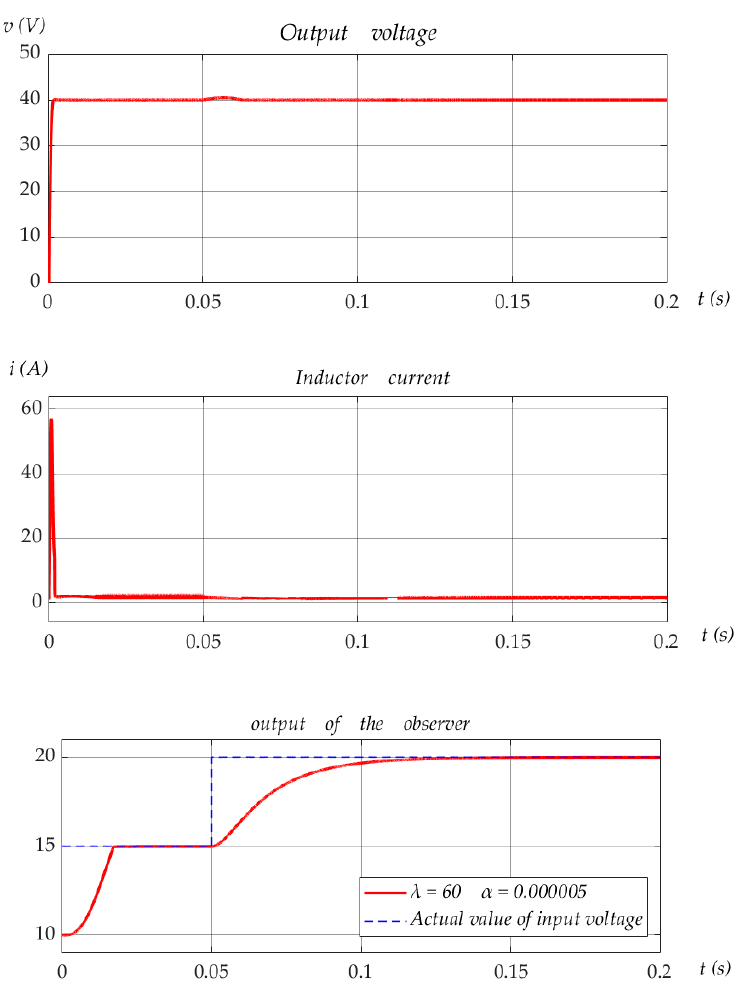
Figure 8. Response curves of boost converter feeding CPL under the proposed controller with the step change in E